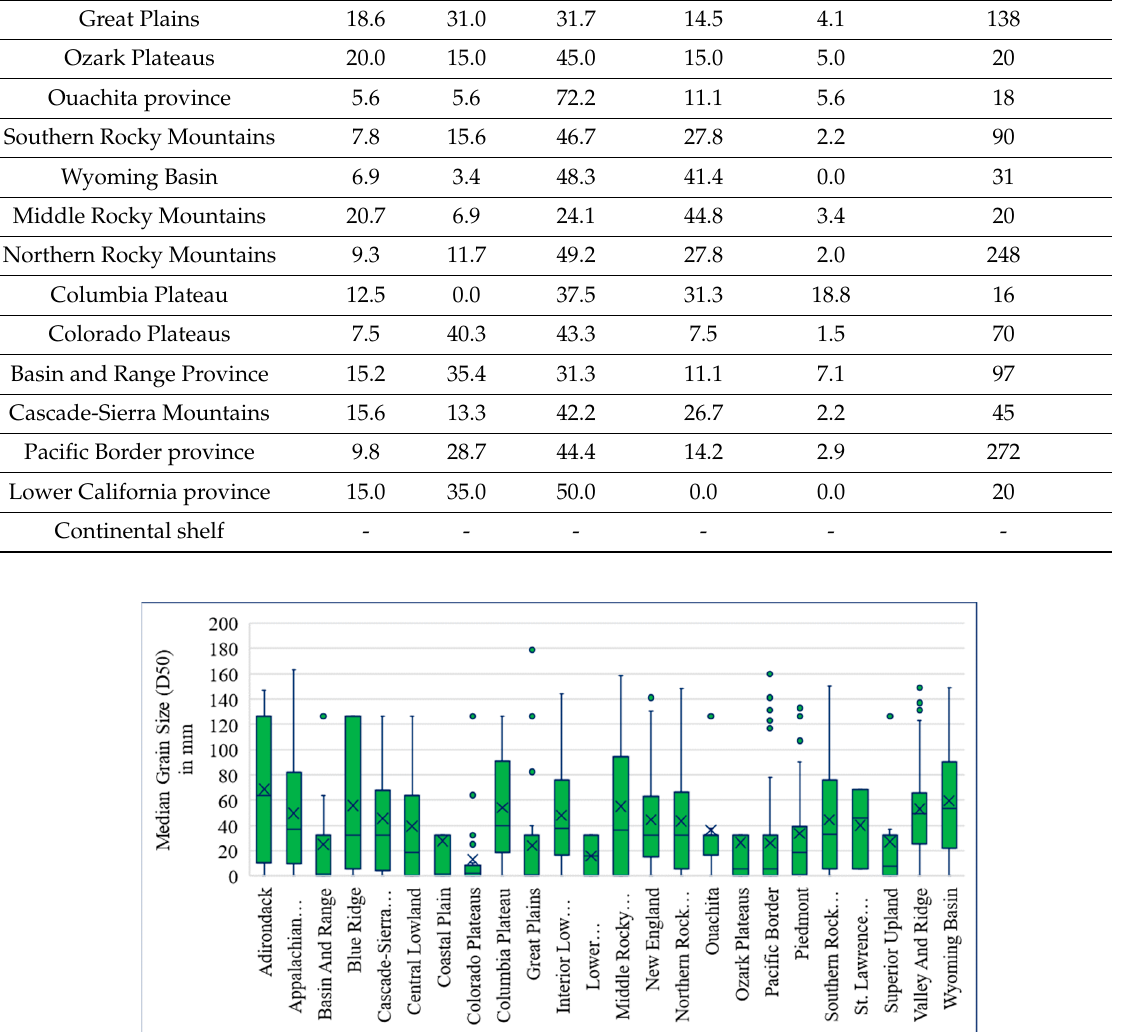
Figure 7. Box Plot showing the range of D50 data over Physiographic Provinces of the U.S.